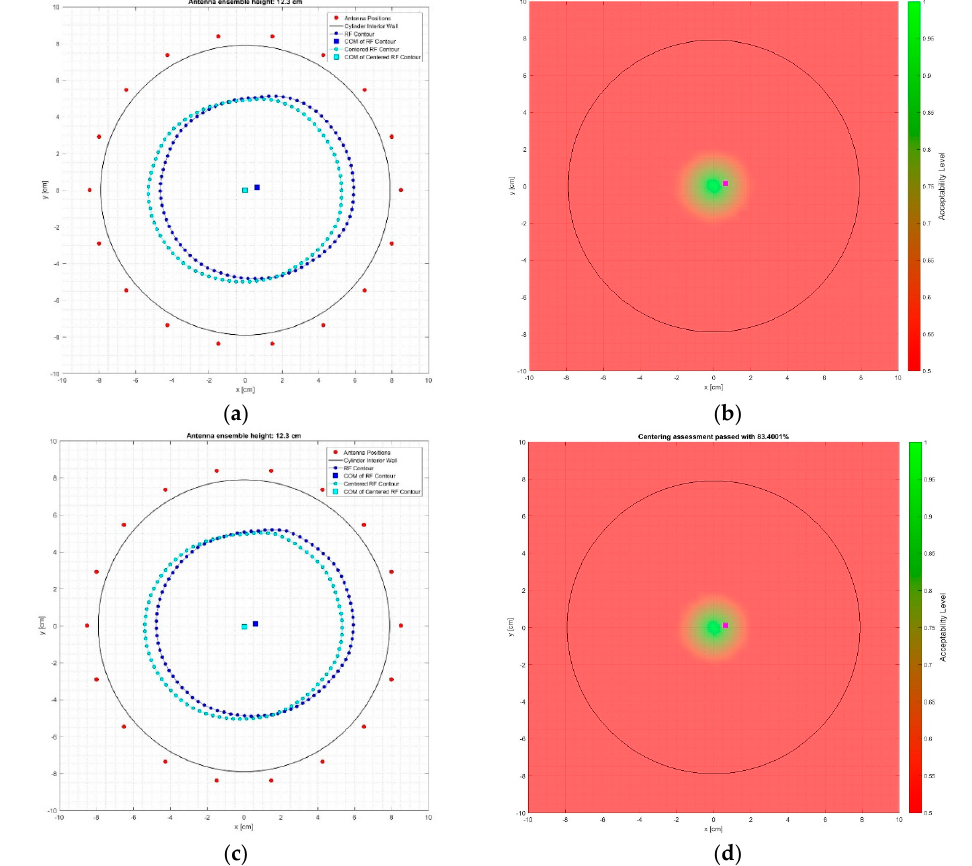
Figure 13. Breast rotational position #1: ( a ) Test Date 1, estimated outer breast surface at a given coronal slice; ( b ) Test Date 1, breast centering assessment map; ( c ) Test Date 2, estimated outer breast surface at a given coronal slice; ( d ) Test Date 2, breast centering assessment map.